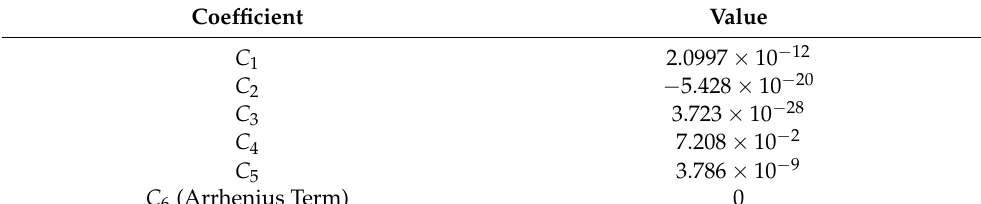
Table 3. Tensile Creep Coefficients from the Group Generalised Time Hardening simulations.